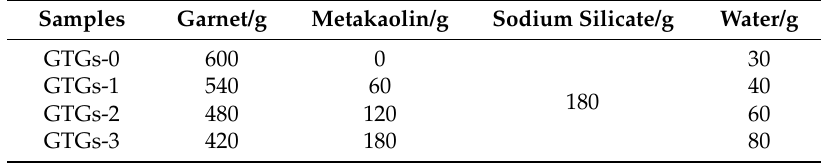
Table 2. The details of the number of raw materials for the geopolymers